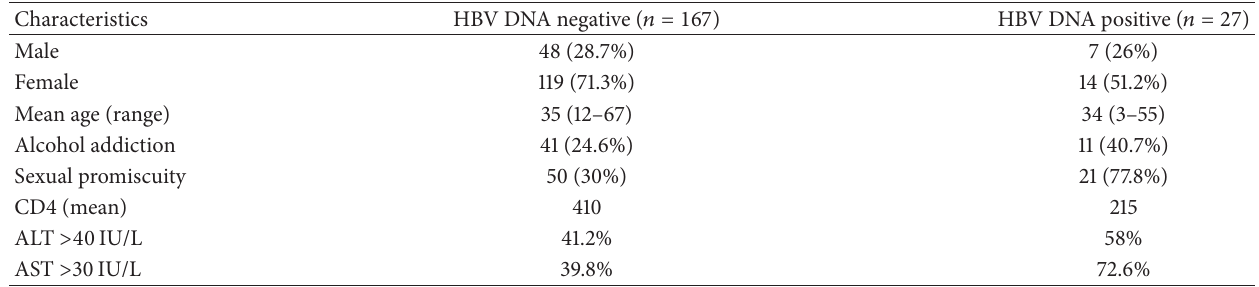
Table 3: Comparison of different demographic, biochemical, and virological factors between HBV DNA positive and HBV DNA negative. Characteristics